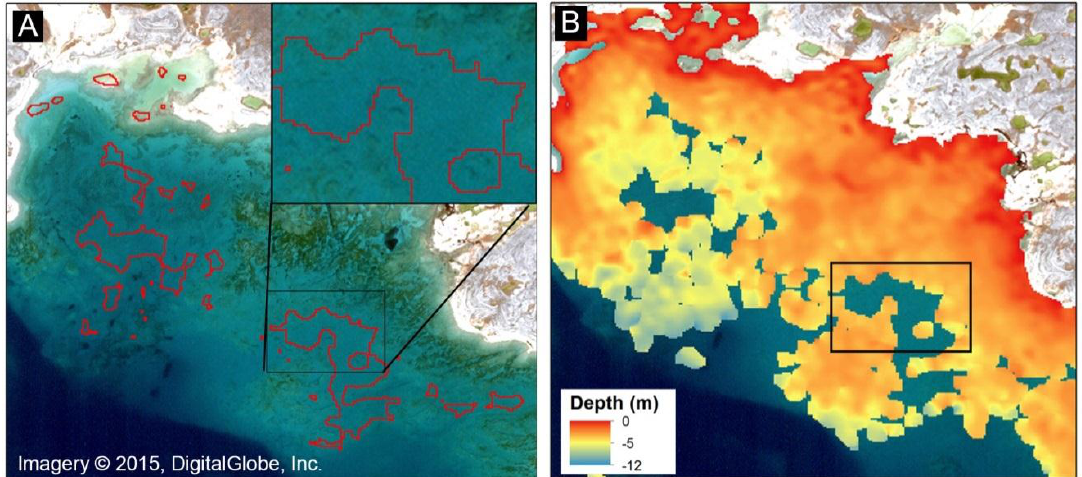
Figure 6. Impact of homogenous bottom types on the automatic approach. ( A ) Homogeneous areas within the WorldView-2 image. ( B ) Illustration of gaps in bathymetry estimates from the automatic approach due to areas of homogeneous bottom.